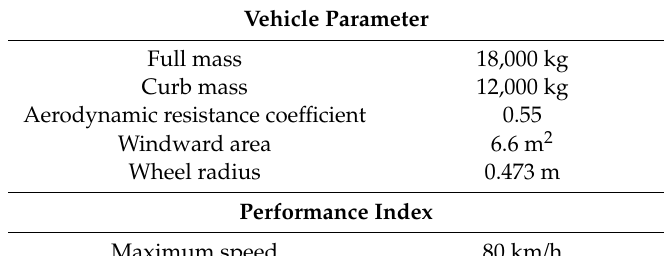
Table 1. Main parameters of PHEV.